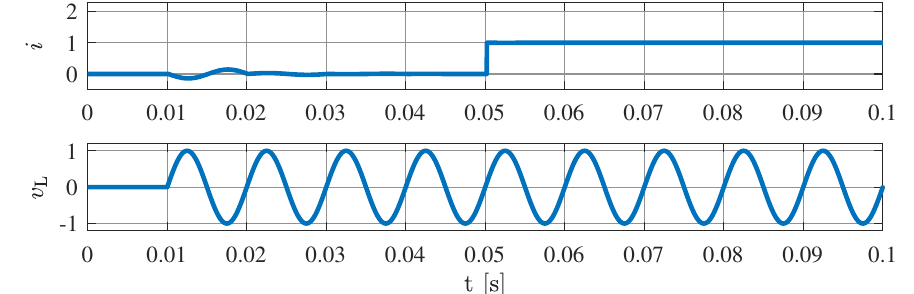
Figure 9. Response of the system to step reference at 0.05 s (output i and periodic disturbance v L ) for a repetitive control insensitive to reference signal changes.